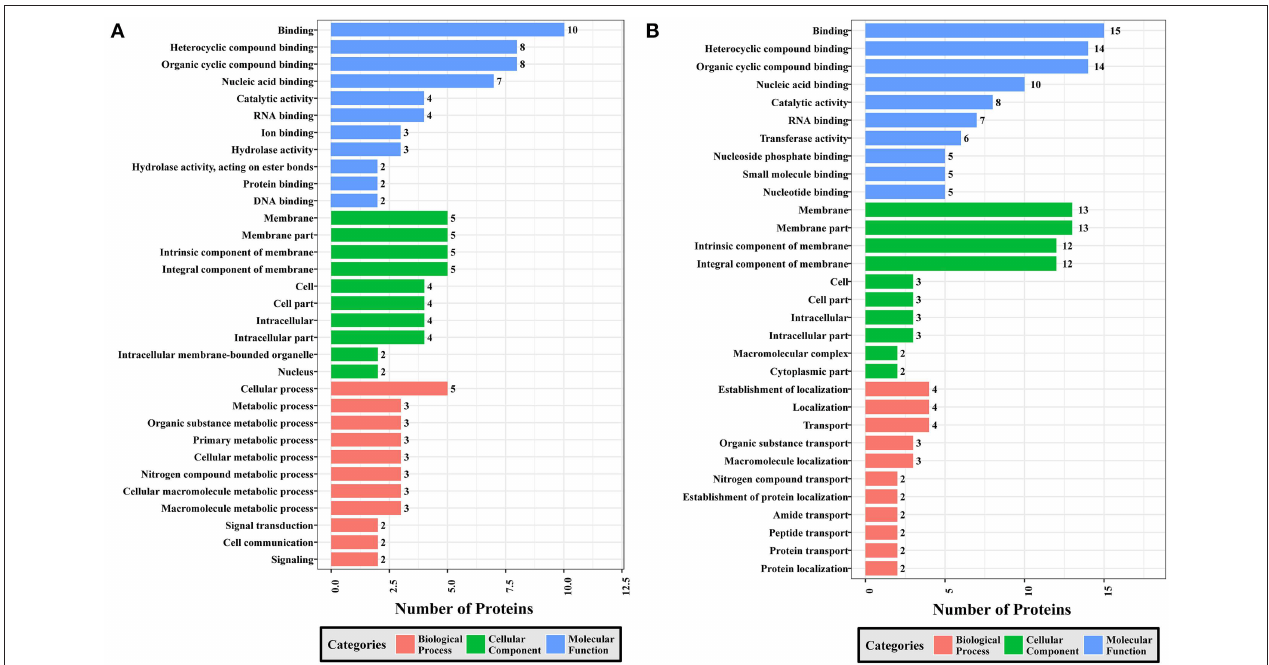
FIGURE 8 | GO analysis of phosphoproteins up/down-regulated in PYS strain when comparing PYS/RH strains. The X-axis indicates the number of DEPs. The Y-axis represents GO terms of (A) upregulated and (B) downregulated phosphoproteins in PYS strain when comparing PYS/RH strains, respectively.